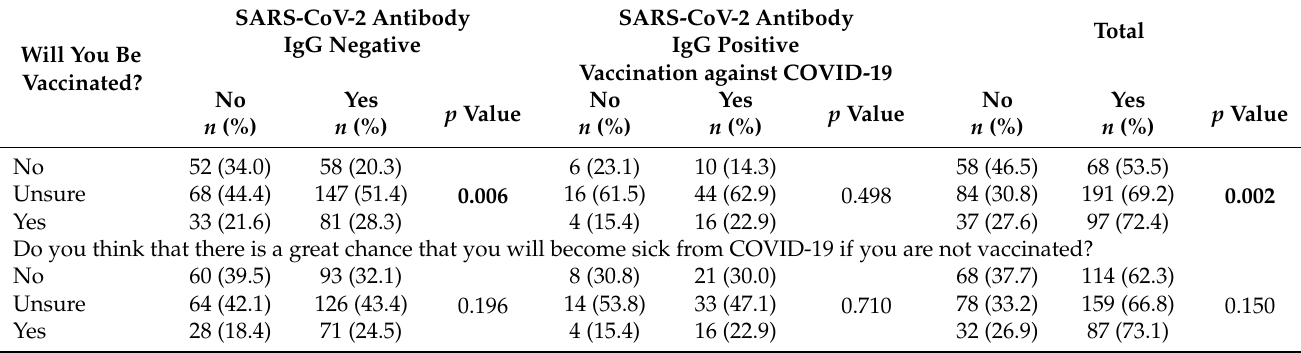
Table 2. Vaccination status during the first nine months of 2021 in relation to attitudes toward vaccination and expected possibility to be infected with COVID-19 in the absence of vaccination.